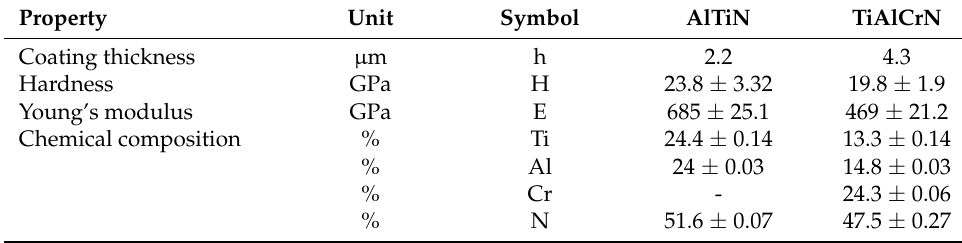
Table 2. Properties of selected coated cutting tool inserts.